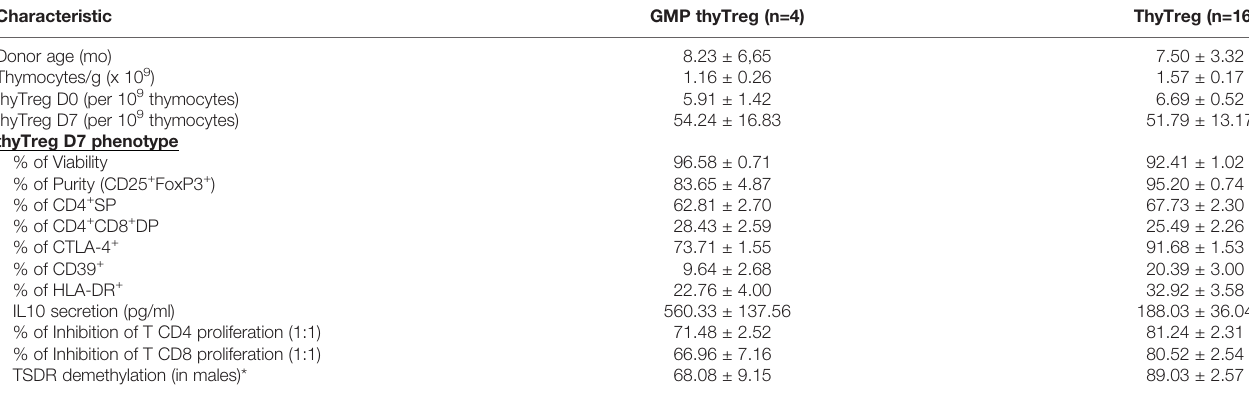
TABLE 2 | Comparison of the main thyTreg characteristics between Research and GMP manufacturing protocol.